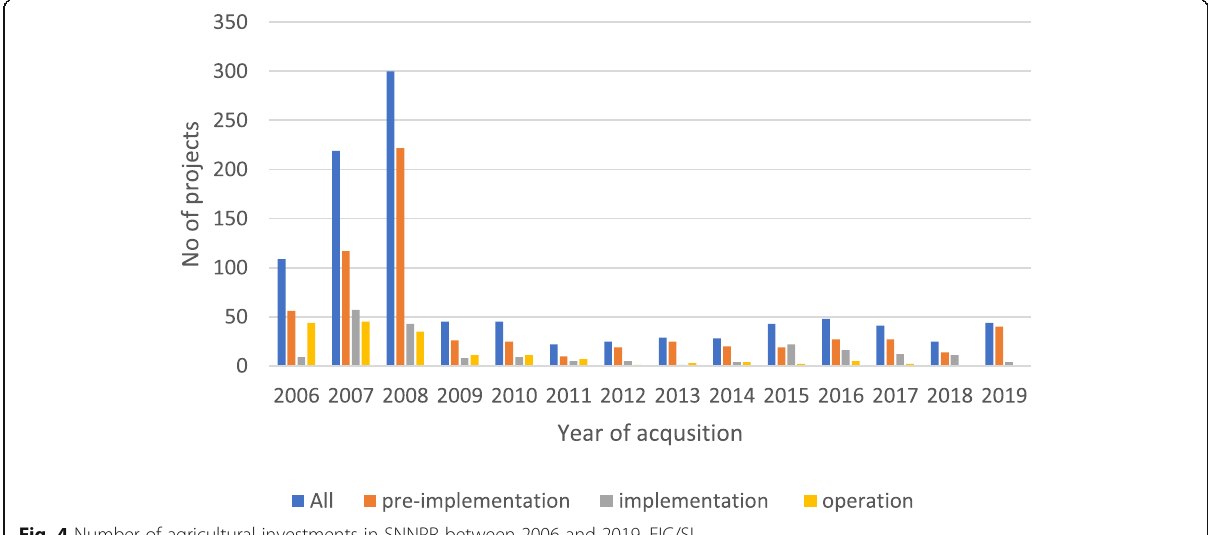
Fig. 4 Number of agricultural investments in SNNPR between 2006 and 2019,